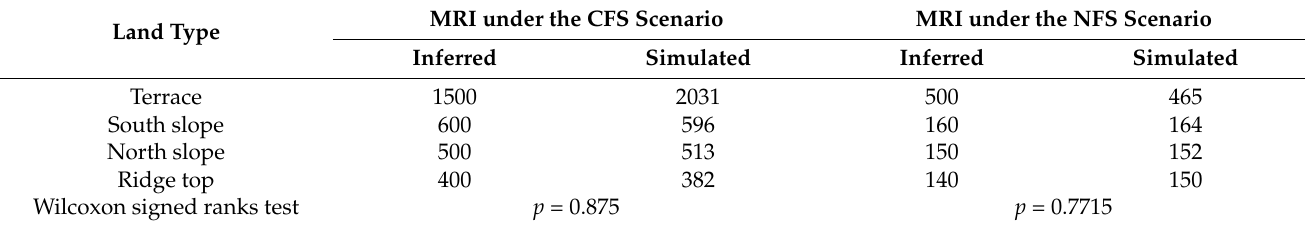
Table 4. Statistical test for mean fire return intervals (MRI) between the inferred and the simulated for the current fire suppression (CFS) and no fire suppression (NFS) scenarios.